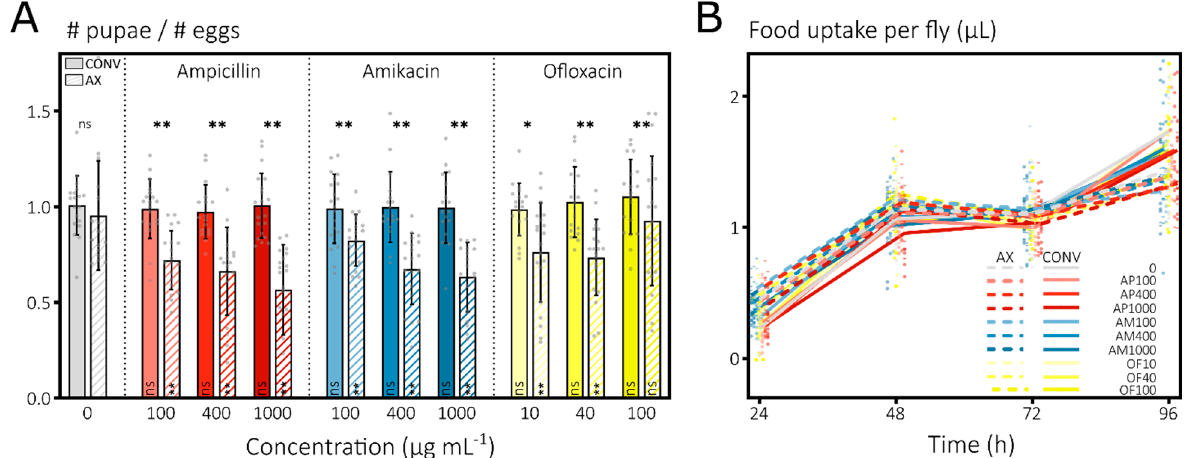
Figure 1. Strong, direct effects of antibiotics on Drosophila melanogaster survival and food uptake are limited to the dechorionated, larval stage. ( A ) Antibiotics elicit strong larval mortality in axenic, antibiotic-treated groups. Conventional eggs (CONV, full bars) or dechorionated eggs with eradicated microbiome by bleach treatment (AX, dashed bars) were deposited on the surface of nutrient agar containing either no antibiotic (gray) or ampicillin (red), amikacin (blue) or ofloxacin (yellow) at different concentrations (shades). The ratio of the cumulative number of pupae by day 14 to the estimated number of eggs at the start was plotted (means ± stdevs with n = ±800 per group across 20 vials as gray points). Linear mixed model (lme) with post hoc tests for significant differences with the untreated control (Dunnett test per AX and CONV groups, in bar) and between AX-CONV per treatment (Tukey, above bar) (ns, nonsignificant; *, p < 0.05; **, p < 0.01). ( B ) Antibiotics have no effect on daily food uptake in adult flies. Uptake of antibiotic-free or -containing liquid food was recorded daily for AX (dotted line) and CONV (full line) flies using capillaries (means, n = ±60 per group across 10 vials shown as full and half points for CONV and AX). Post hoc tests on an lme with the untreated control (Dunnett) and between AX-CONV per treatment (Tukey) were nonsignificant for all contrasts.